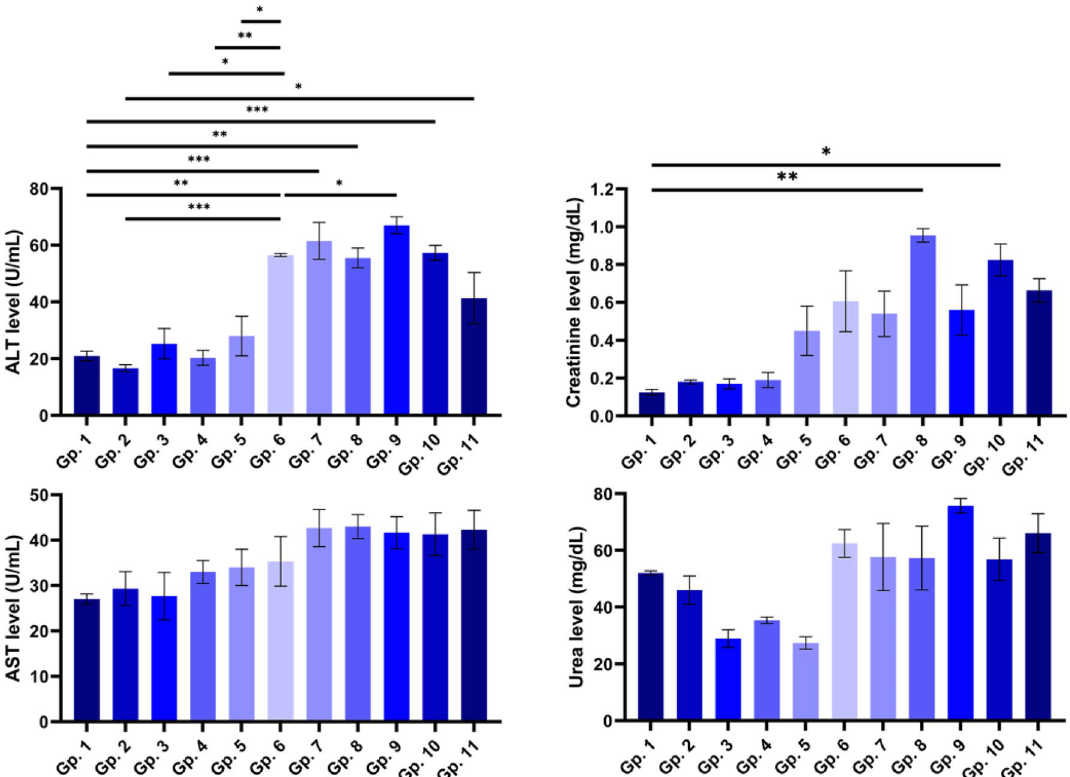
Figure 7. Effect of BV, irradiated BV, CS-NPs, and BV-loaded CS-NPs on ALT level, AST level, creatinine level, and urea level in studied groups. Gp.1: Mice injected with PBS as a control group, Gp.2: Mice injected with BV, Gp.3: Mice injected with irradiated BV, Gp.4: Mice injected with CS-NPs, Gp.5: Mice injected with BV-loaded CS-NPs, Gp.6: Infected mice with S. aureus , Gp.7: Infected mice treated with BV, Gp.8: Infected mice treated with irradiated BV, Gp.9: Infected mice treated with CS-NPs, Gp.10: Infected mice treated with BV–loaded CS-NPs, Gp.11: Infected mice treated with the antibiotic. Data were analyzed using one-way ANOVA and represented as Mean ± Standard Error of mean (SEM). (*) is considered significant P < 0.05, (**) is considered highly significant P < 0.01, (***) is considered highly significant P <